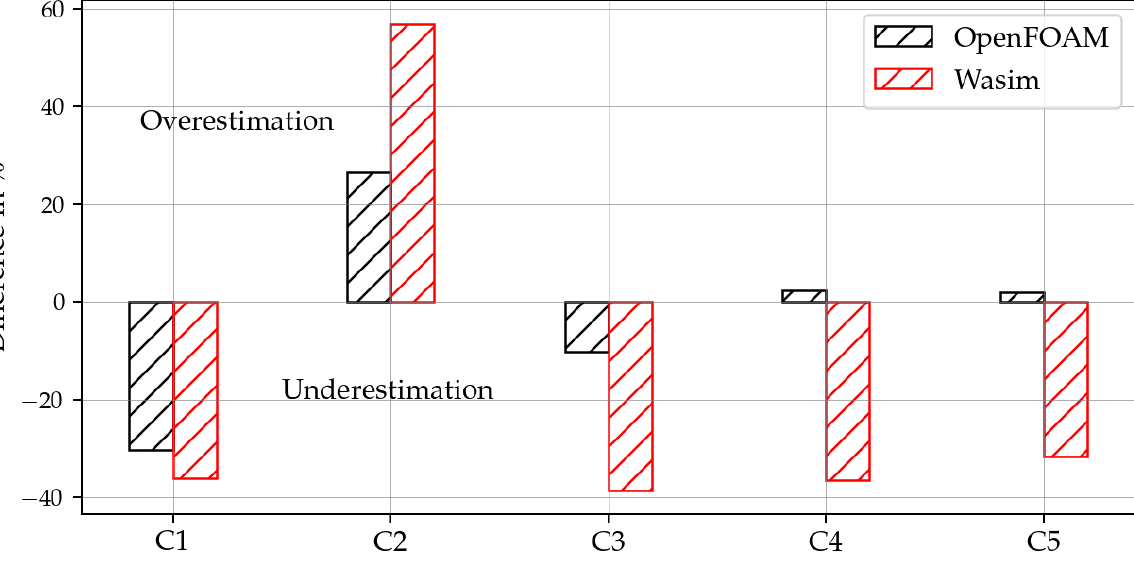
Figure 31. Difference of numerical and experimental pitch transfer functions for the KRISO contain- ership.